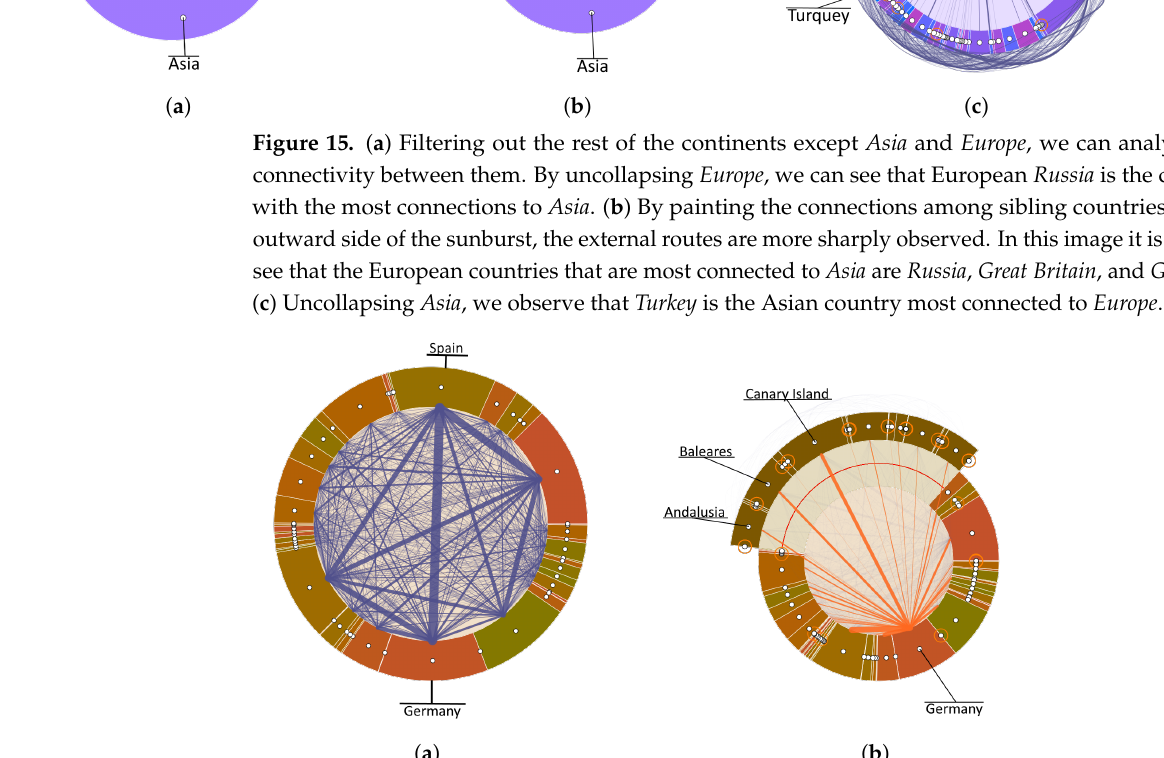
Figure 16. ( a ) Focusing on Europe , the most highly connected countries are Germany and Spain . ( b ) Uncollapsing, applying a magnification on Spain , and highlighting the connections from Germany reveals that the majority of the routes between Germany and Spain are with the Canary Islands , followed by the Balearic Islands and Andalusia region.